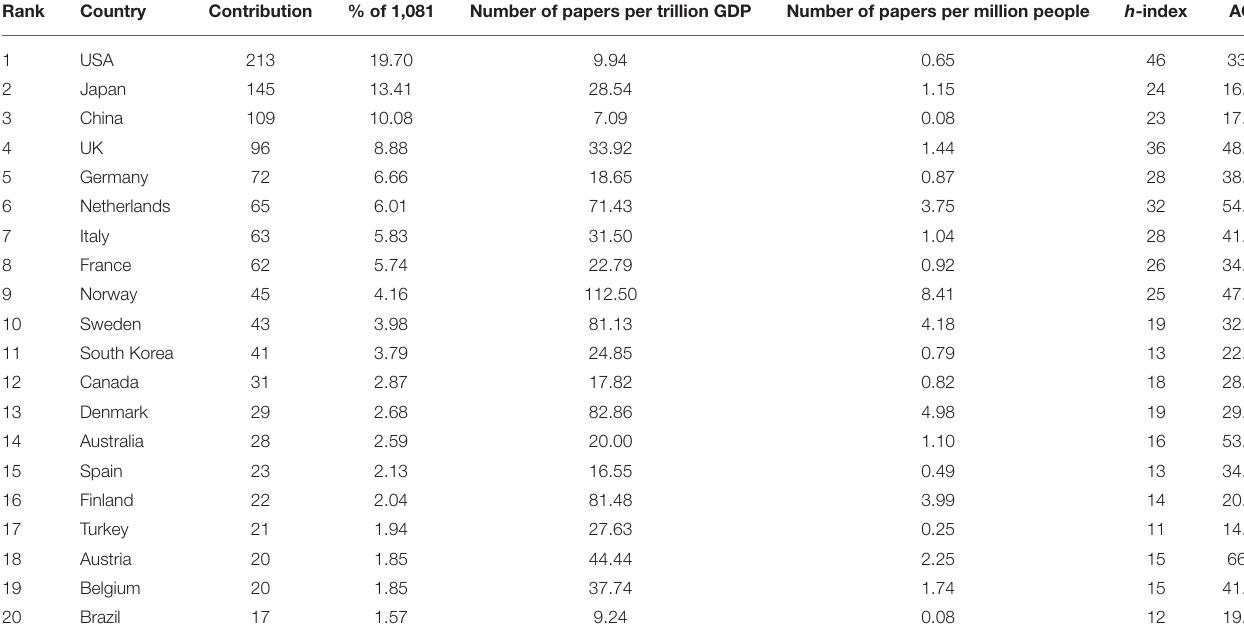
TABLE 1 | Top 20 countries with the most publications related to ORA research.